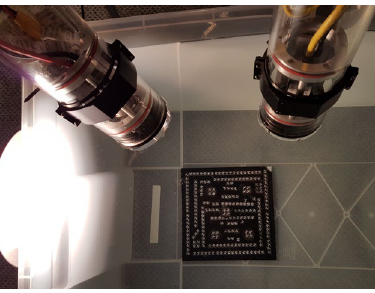
Figure 9. Convergent underwater stereo camera observing a test field underwater.